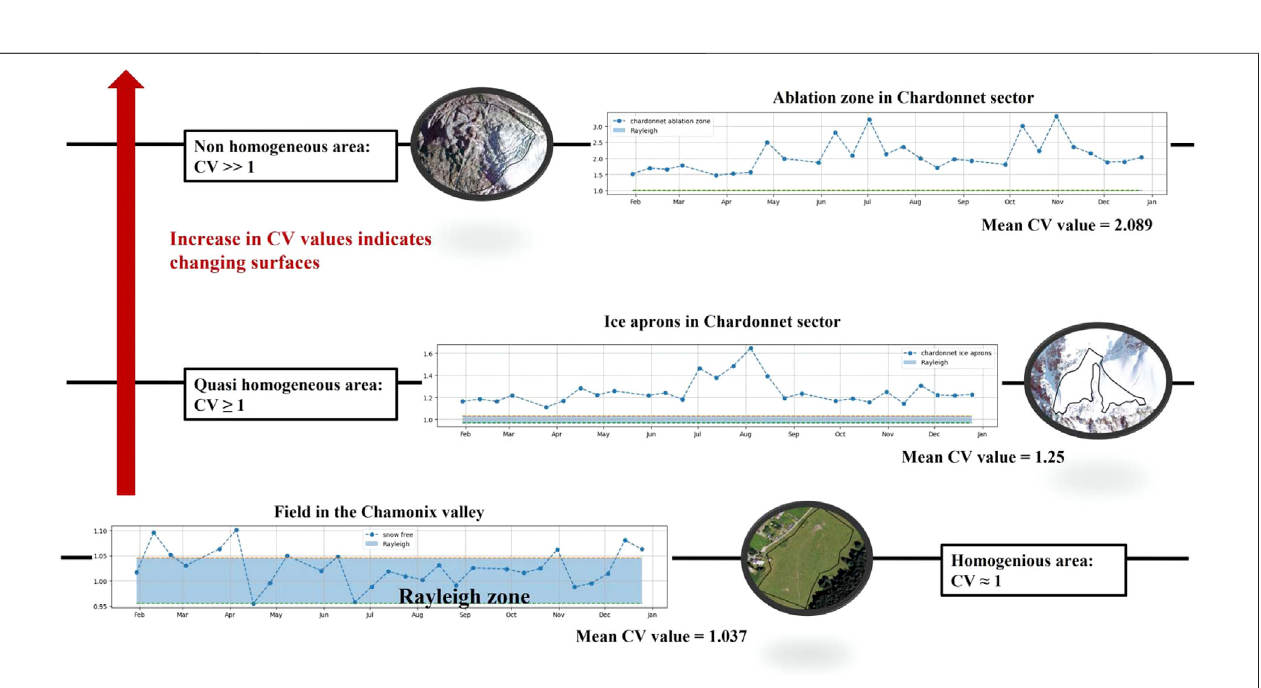
Frontiers in Remote Sensing |